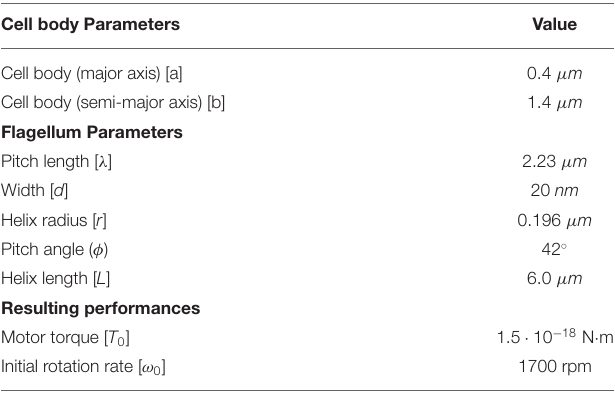
TABLE 1 | Cell and flagellum properties used in resistive force theory (RFT) and modified resistive force theory (mRFT) to calculate cell motion. Cell body